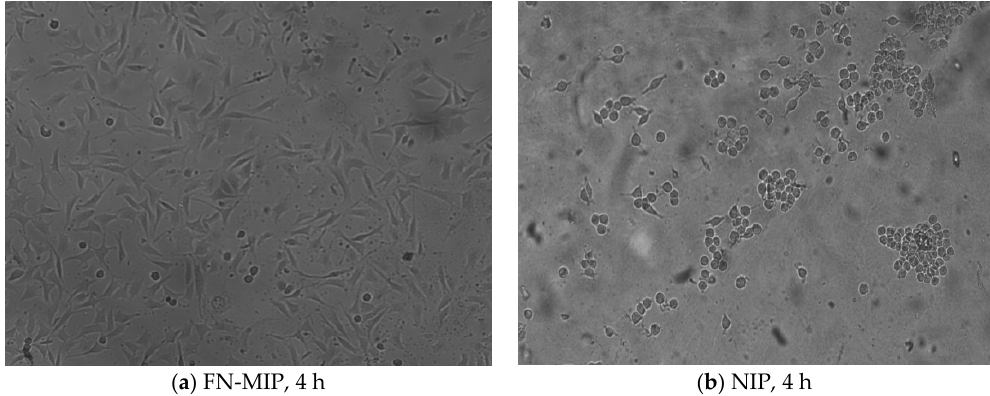
Figure 12. Photographs of adhesive L929 cells on MIP and NIP after cultured for 4 h.